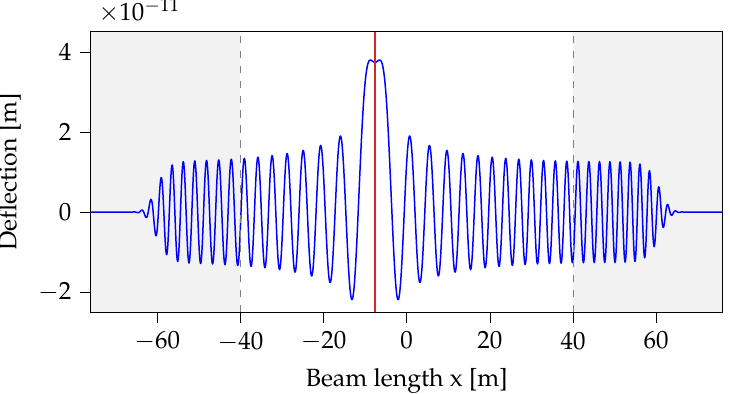
Figure 9. Deflection of the beam’s continuous single-layer elastic foundation at t = 0.05 s; gray areas: boundary domains, vertical red line: driving